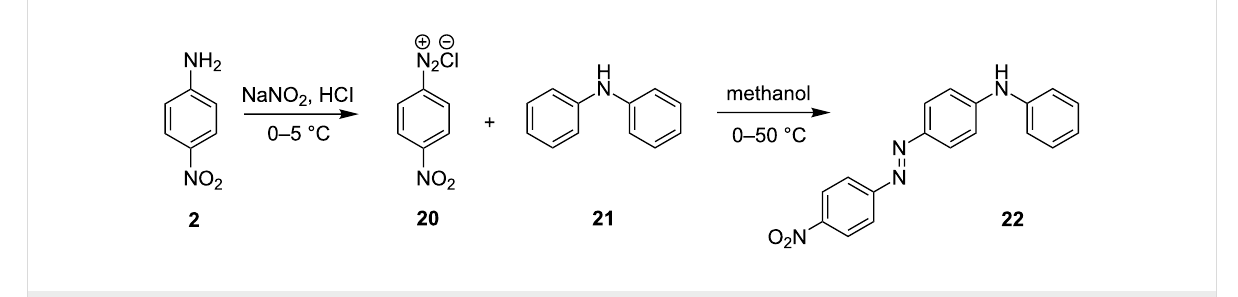
Scheme 7: Azo coupling reaction under acidic conditions.